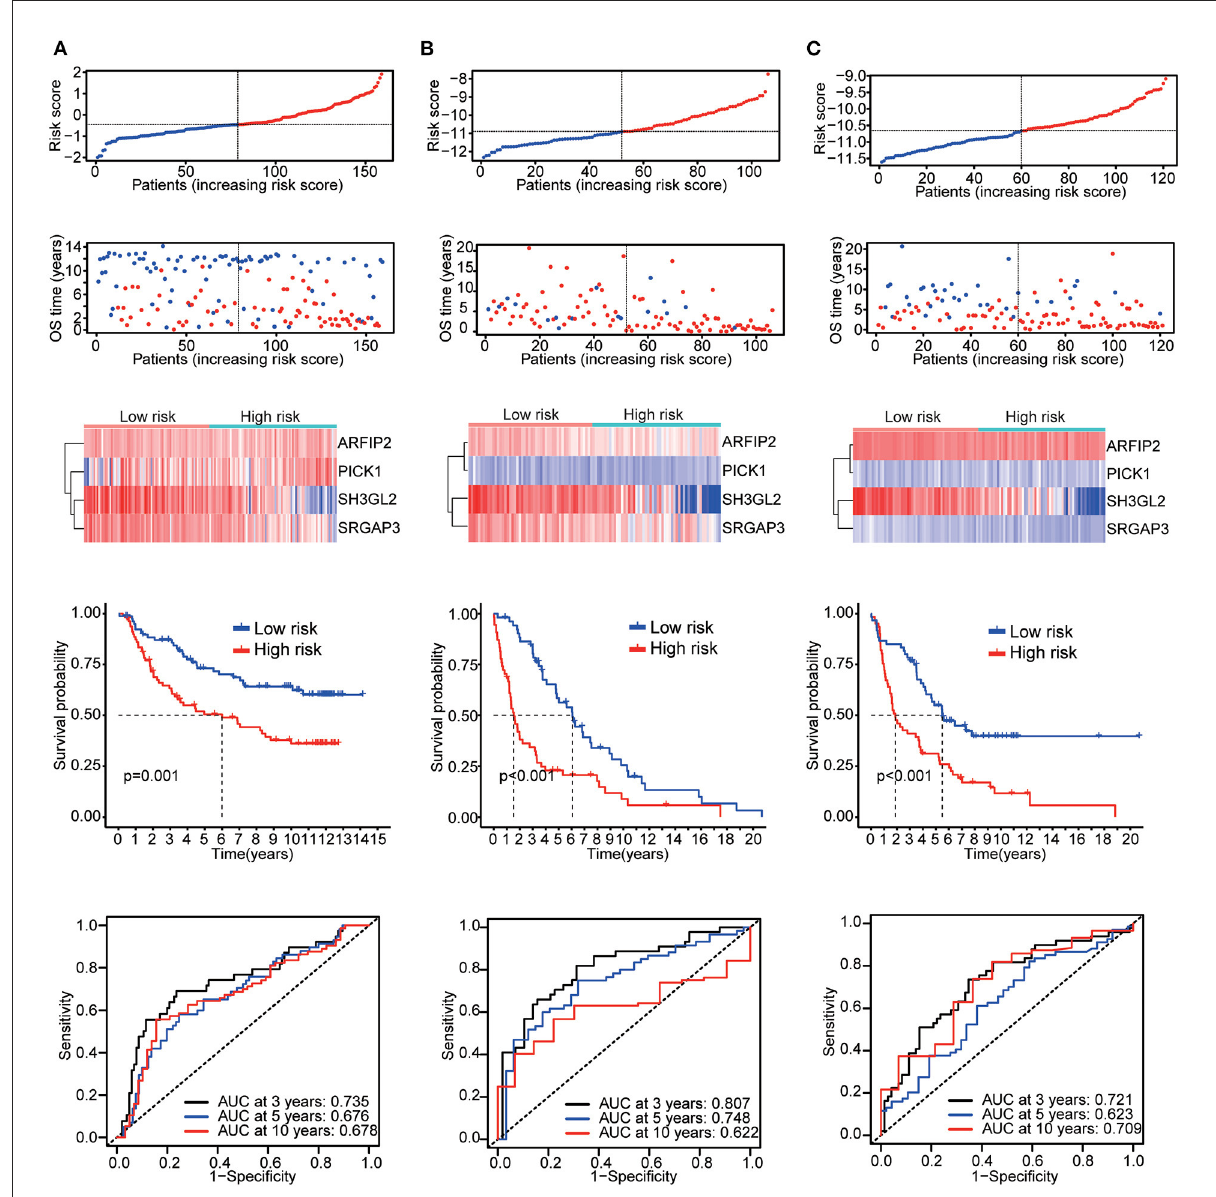
FIGURE5 Validation results (A) CGGA array_301 cohort. (B) Rembrandt microarray cohort. (C) GSE16011